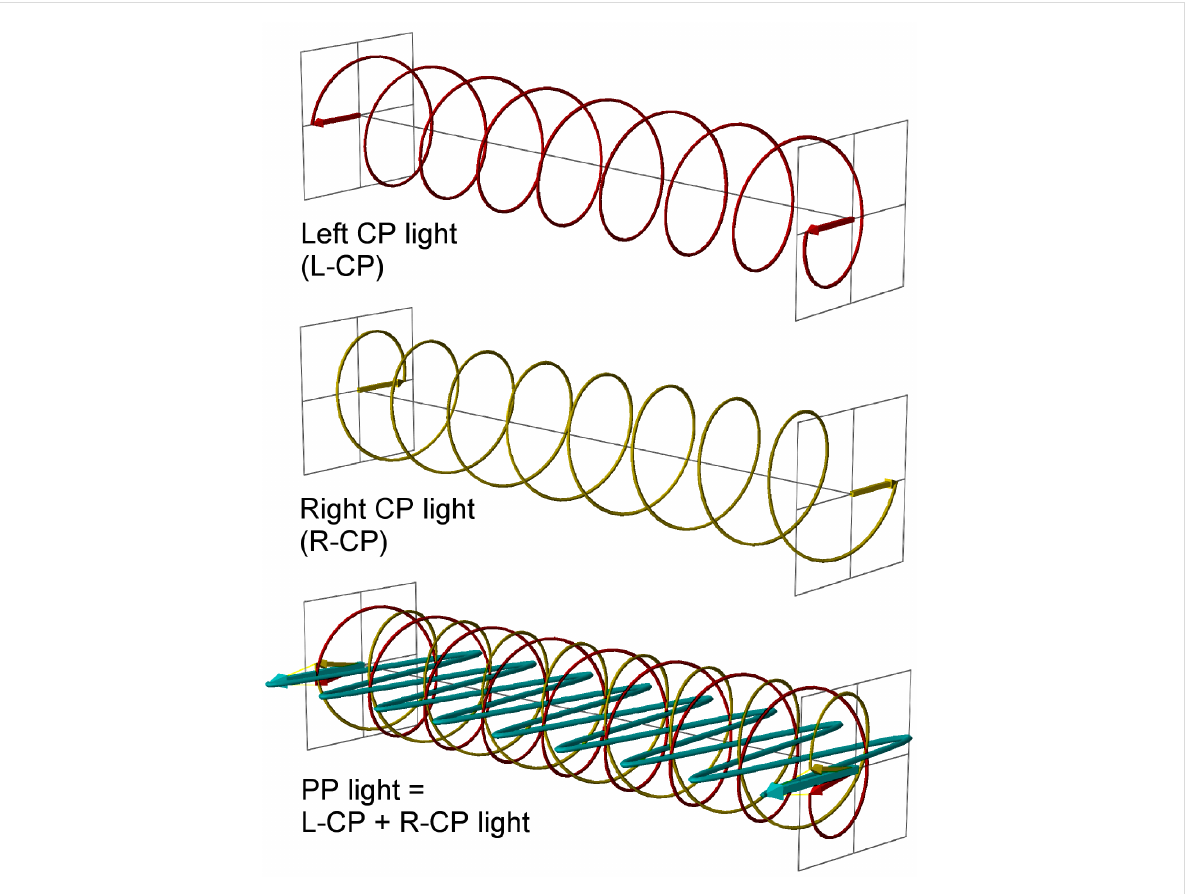
Figure 1: Plane polarized light (PP, cyan) as the sum of the left and right circularly polarized light (L-CP, red, and R-CP, yellow). L-CP is defined as such as an observer far from the source (on the right side of the figure) will see a vector describing an anti-clockwise circle.